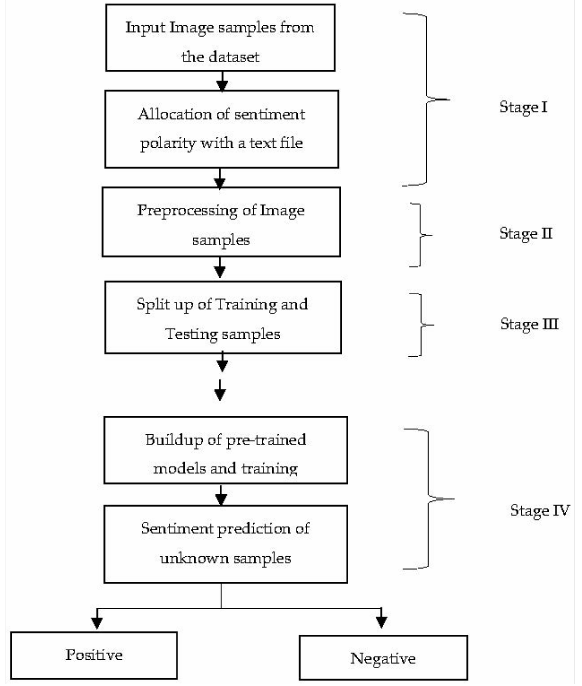
Figure 1. Flow diagram of the image sentiment prediction